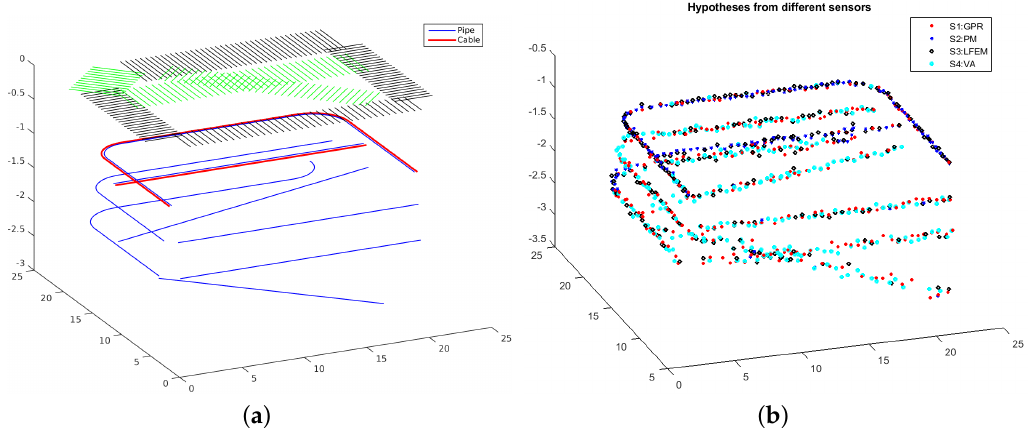
Figure 6. ( a ) A synthetic environment with several groups of scan lines on the ground surface and some utilities below the surface (three curved pipes, five straight pipes, one curved cable and one straight cable). The surveyed regions with green and black grids represent the grass covered-area and the tarmac area, respectively. A utility represented by a blue line is a pipe and otherwise a cable; ( b ) A group of synthetic hypothesized detections generated with the simulator with respect to the aforementioned synthetic environment for four sensors: GPR, PMF, Low Frequency Electromagnetic Fields (LFEM) and VA (best viewed in colour).